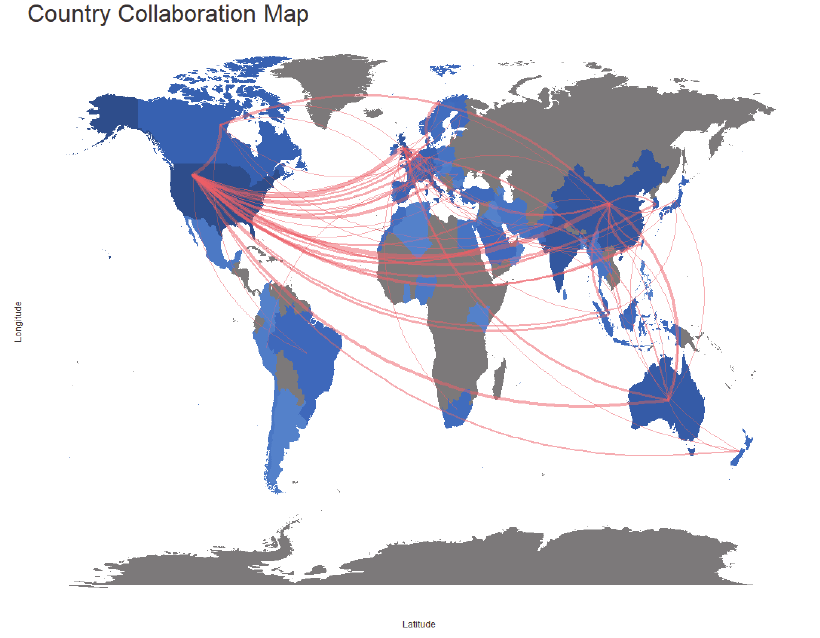
Fig. 1. Word Map collaboration (Social Structure)